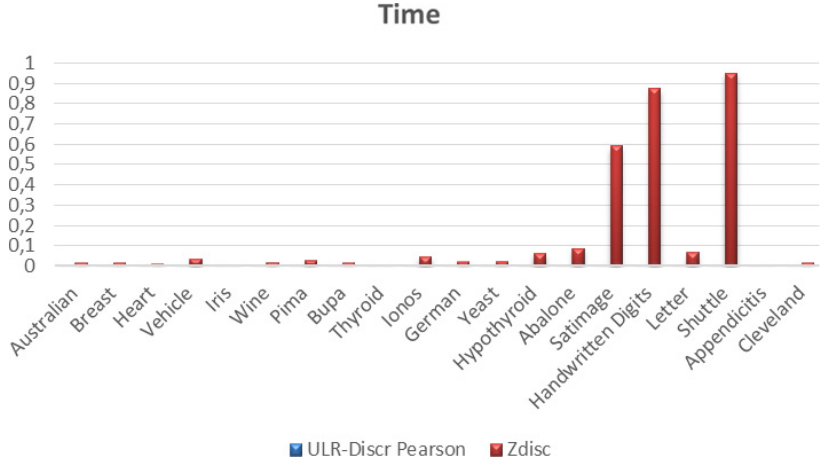
Fig. 7. Comparing time for ULR-Discr using the Pearson coe±cient and ZDisc.